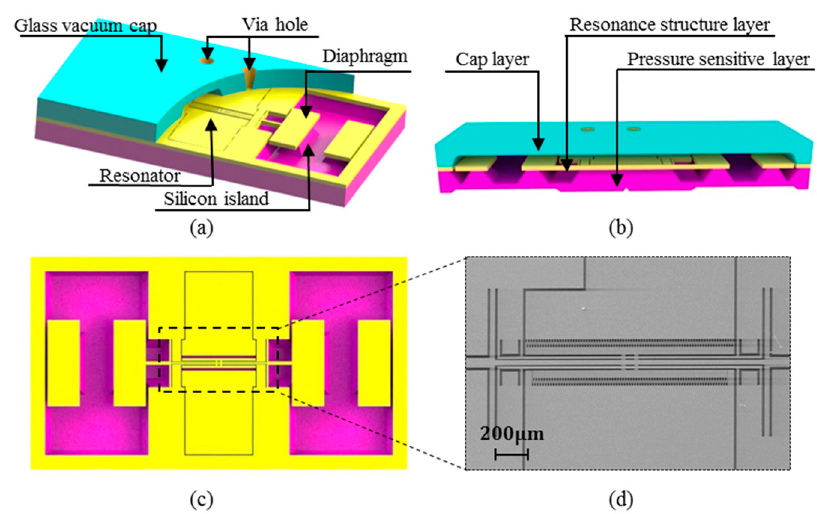
Figure 1. Schematic of the designed resonant pressure sensor without electrode wire layer. The blue, yellow, and pink layers represents the glass vacuum cap layer, the resonance structure layer, and the pressure sensitive layer, respectively. ( a ) Sectional view of the main surface of the resonant pressure sensor; ( b ) Sectional view of the resonant pressure sensor; ( c ) The resonance structure layer with each diaphragm attached to one end of the resonator by a silicon island; ( d ) The stable resonator for frequency output.